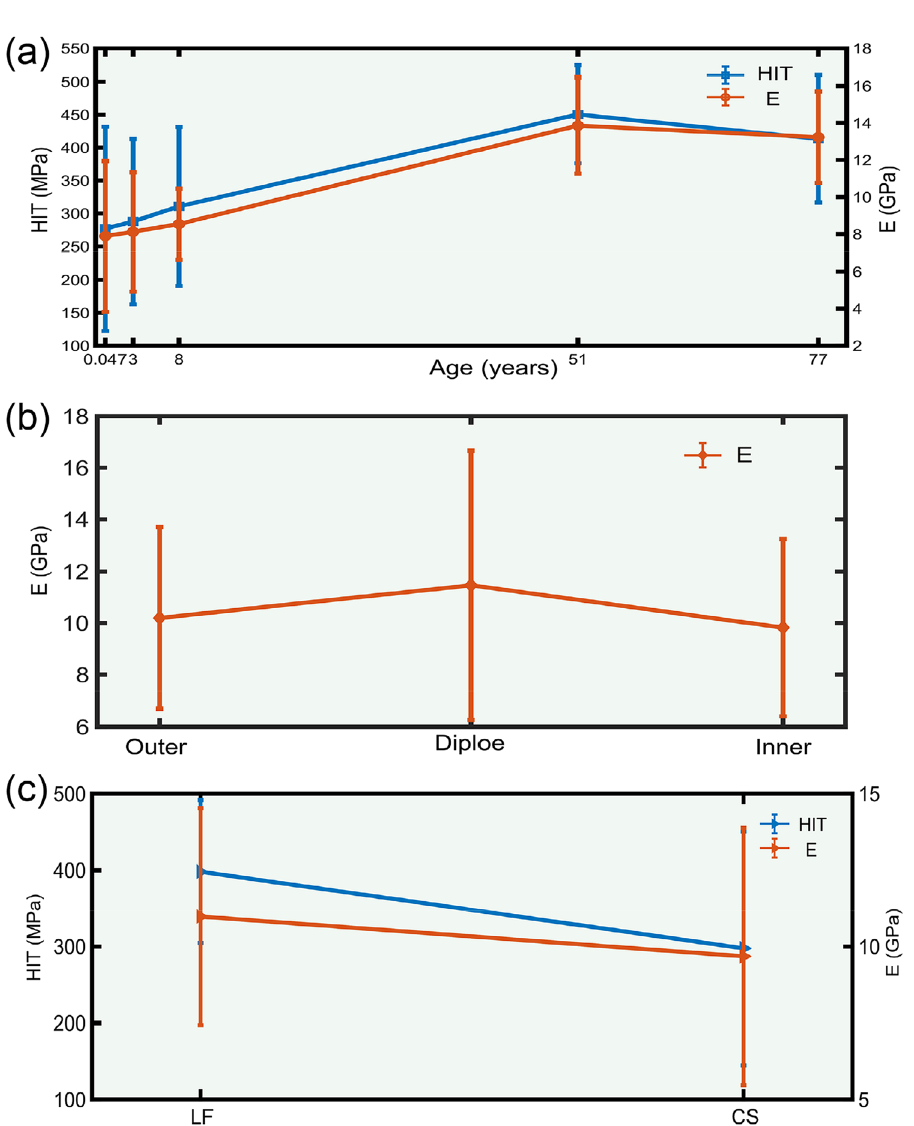
Figure 5. One-way analysis of variance of HIT and E based on different ages, layers and locations. The ( a ) is the HIT and E changing trend of LF and CS at different ages; ( b ) is the E difference of different structures of inner plate, diploe and outer plate; ( c ) is the difference comparison of different parts (LF and